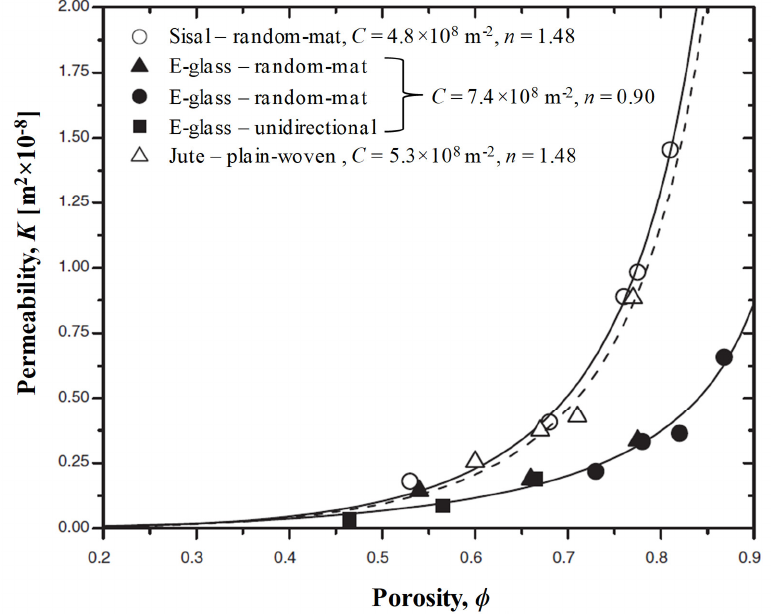
Figure 4. Comparison of the (unsaturated) permeability of sisal, jute, and E-glass reinforcements impregnated with glycerin solution (glycerin / water ratio of 0.88:0.12) at ambient temperature and viscosity of 1.2 Pa · s. Carman–Kozeny constants (C and n, Equation (5)) are also provided. Adapted from [23], with permission © 2004 Sage. Table 2. In-plane permeability data for various plant fibre reinforcements. Carman – Kozeny constants (C and n, Equation (5)) are provided. It is specified whether data are for transverse or through- thickness saturation.